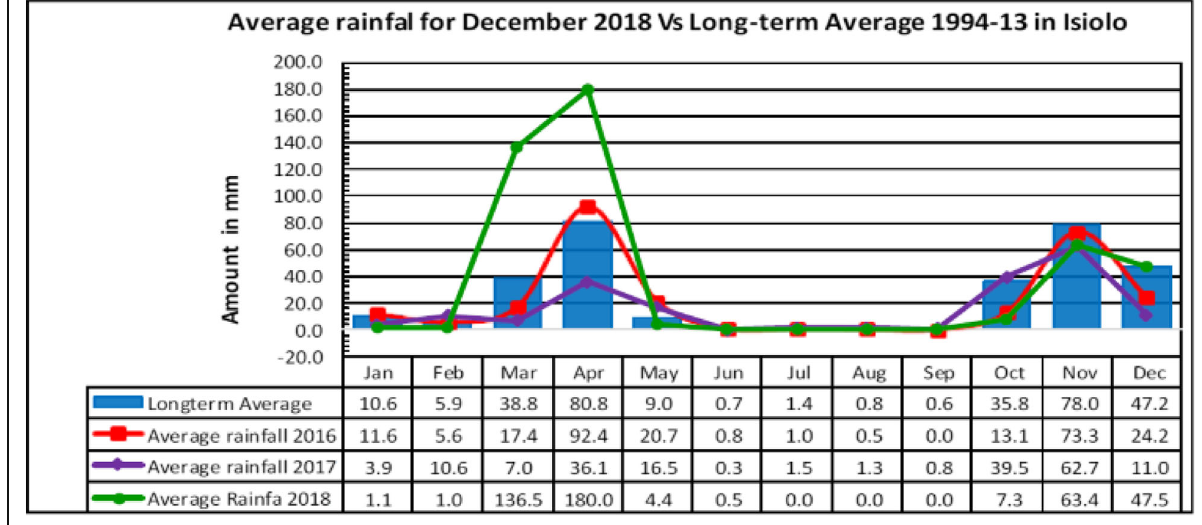
Fig. 3 A graph showing the monthly rainfall data for Isiolo County. Source: NDMA